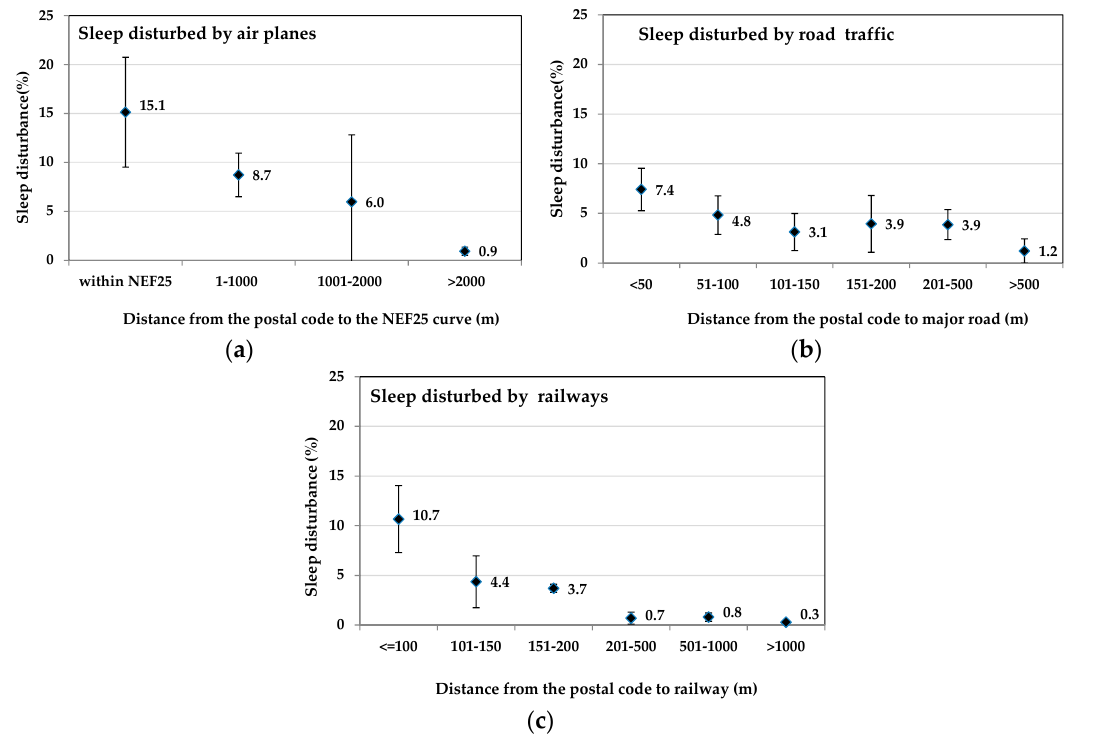
Figure 2. Distance to aircraft NEF25 ( a ), major road ( b ), railways ( c ) and marginal proportions and 95% CI of sleep disturbance by railways in the weighted study